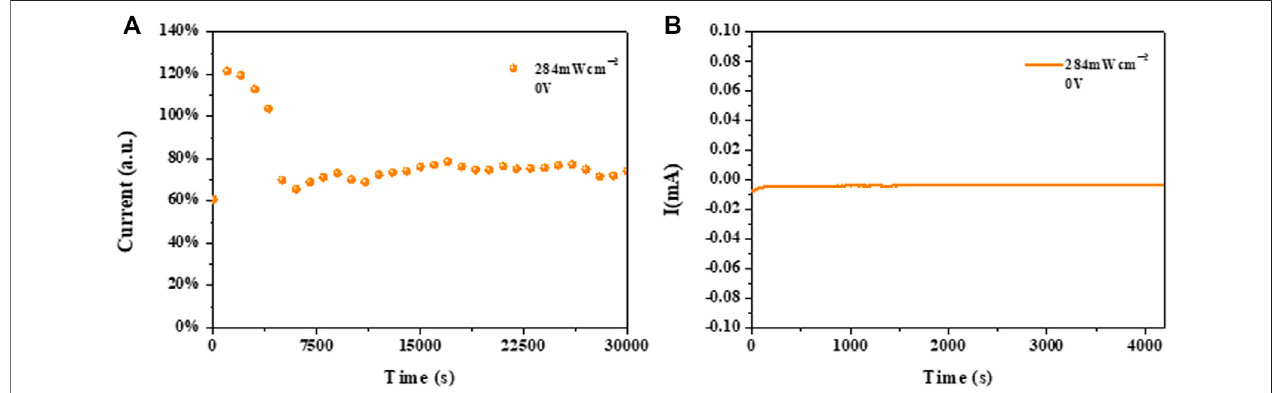
FIGURE 7 | (A) Operational stability of a MAPb 0.5 Sn 0.5 I 3 single-crystal device under 284 mW/cm 2 905 nm near-infrared light with continuous illumination at zero bias. (B) Response current stability of device based on a MAPb 0.5 Sn 0.5 I 3 single crystal under 284 mW/cm 2